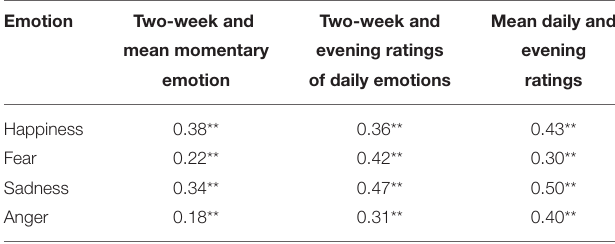
TABLE 1 | Pearson correlations between mean momentary emotion ratings, evening ratings, and 2-week ratings of respective emotions. Emotion Two-week